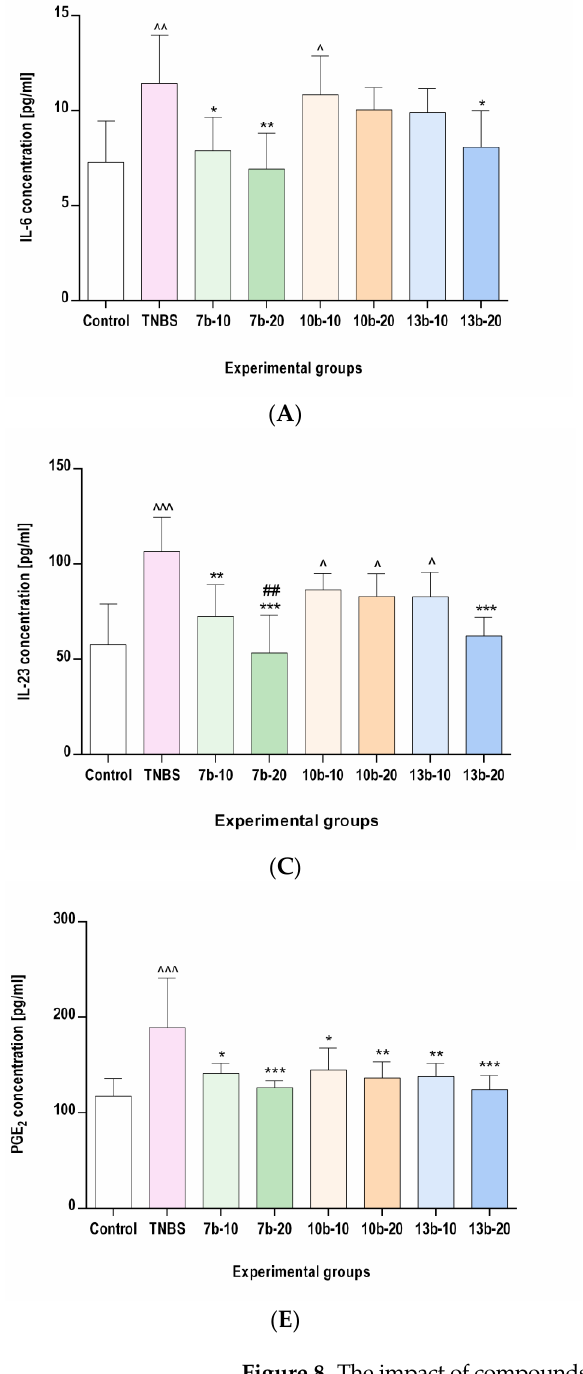
Figure 8. The impact of compounds 7b , 10b, and 13b on IL-6 ( A ), IL-17 ( B ), IL-23 ( C ), TNF- α ( D ), PGE 2 ( E ), and IL-10 ( F ) concentrations in the colon tissues in experimental groups. Control, control group; TNBS, group receiving only TNBS; 7b -10 and 7b -20, groups receiving, respectively, 10 or 20 mg/kg of compound 7b and TNBS; 10b -10 and 10b -20, groups receiving, respectively, 10 or 20 mg/kg of compound 10b and TNBS; 13b -10 and 13b -20, groups receiving, respectively, 10 or 20 mg/kg of compound 13b and TNBS. Data are presented as mean values ± SD; n = 10 for each group. Analyses were performed using the one-way ANOVA and Tukey’s post hoc test. Differences ˆ p < 0.05, ˆˆ p < 0.01, ˆˆˆ p < 0.001 vs. control group; * p < 0.05, ** p < 0.01, *** p < 0.001 vs. TNBS group; ## p < 0.01 vs. compound 10b at the corresponding dose group were deemed statistically